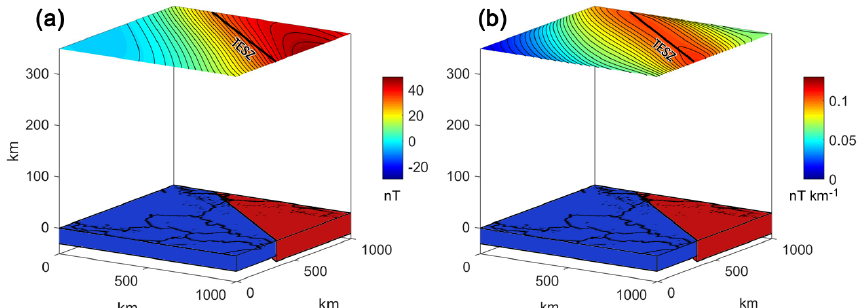
Figure 7. Contact-like 3-D model of central Europe and related magnetic field (a) and total gradient intensity (b) at 350km of altitude. This model refers to hypothesis B described in this paper, wherein the main magnetic source is a magnetic contact between the Paleozoic Platform (blue body) and the Precambrian platform (red